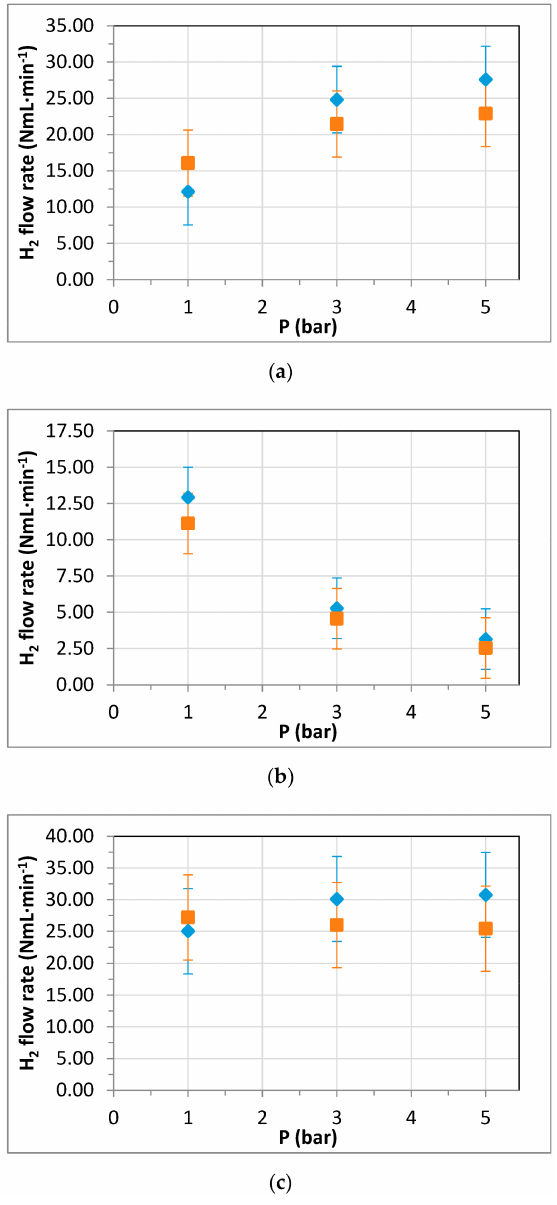
Figure 18. Effect of pressure in OMW–ethanol co-reforming experimental tests (@ 450 ◦ C, ethanol con- centration 7.5 vol.%, feed: 15 g · h − 1 mixture and 15 mL · min − 1 carrier gas): ( a ) permeate, ( b ) retentate, and ( c ) total produced H 2 . Diamonds ( (cid:7) ) represent experiments with N 2 , while squares ( (cid:4) ) are obtained with air as the carrier gas. Reprinted from Alique et al.